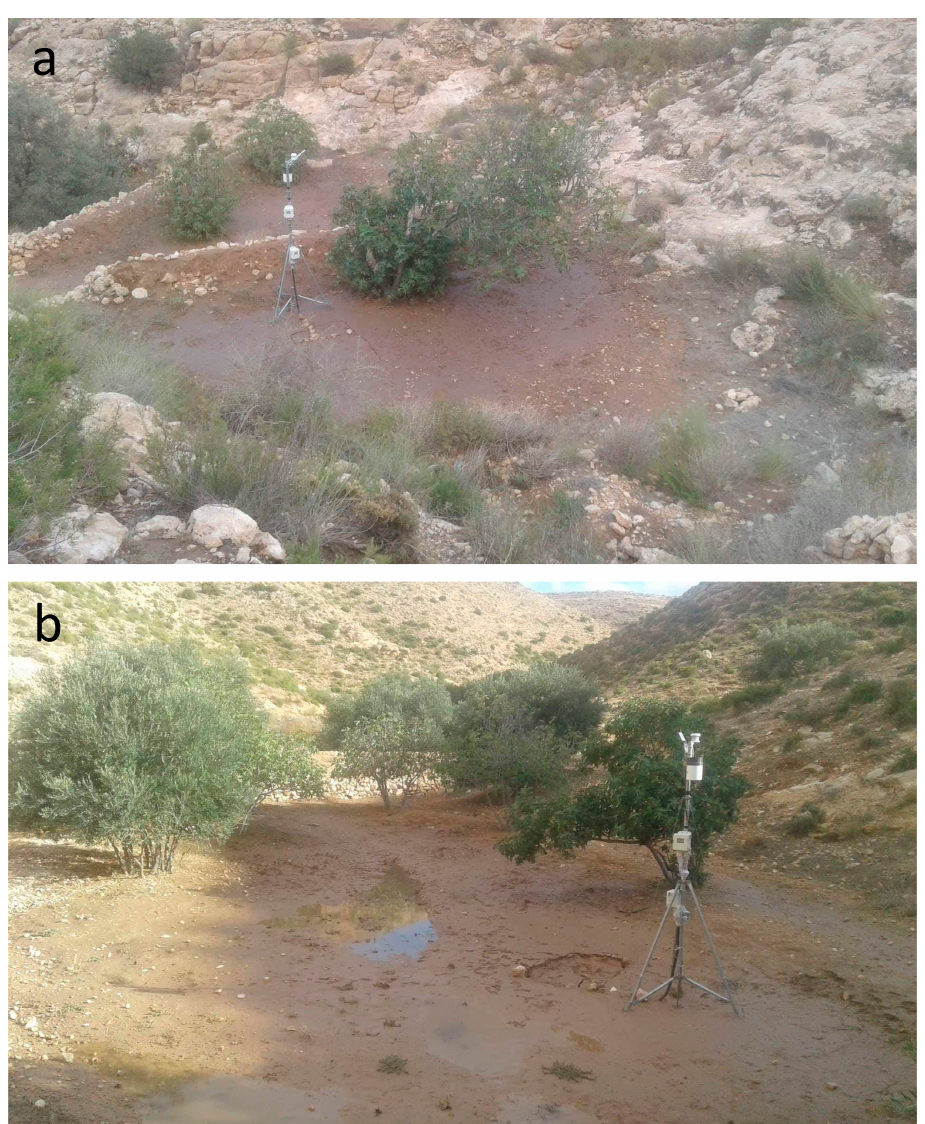
Figure 9. Upstream ( a ) and downstream ( b ) Jessour in Zmerten with the soil surface still saturated one day after the 27 September 2018 rainfall. Photos: M. Abbassi. one day after the 27 September 2018 rainfall. Photos: M.